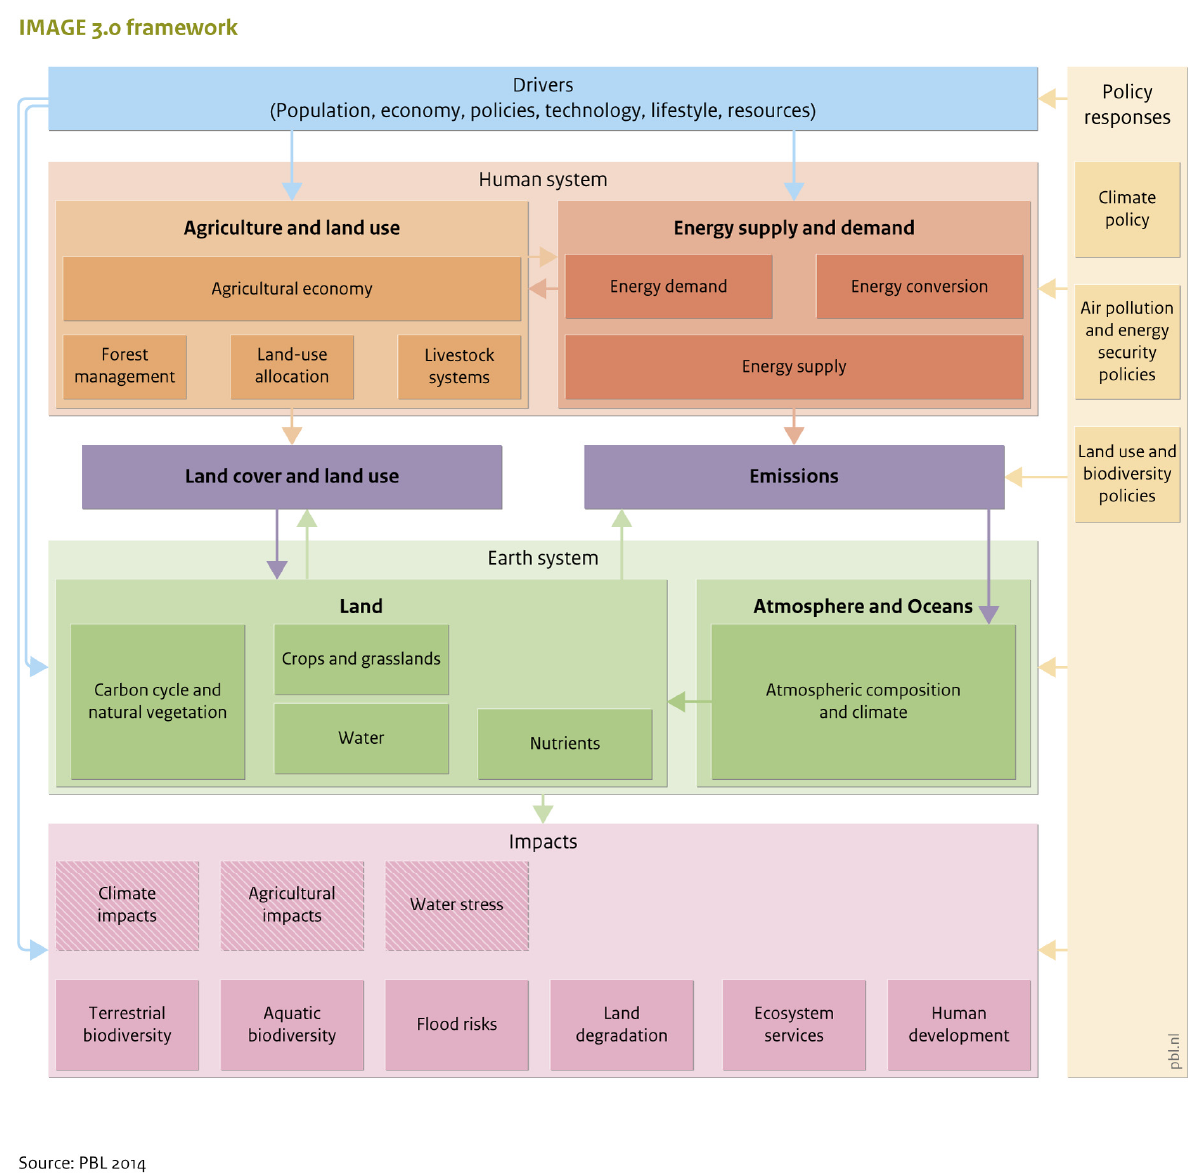
Figure A1. An overview of the IMAGE framework and its components, reproduced from https://models.pbl.nl/image/index.php/IMAGE_framework_summary (accessed 10 January 2021).